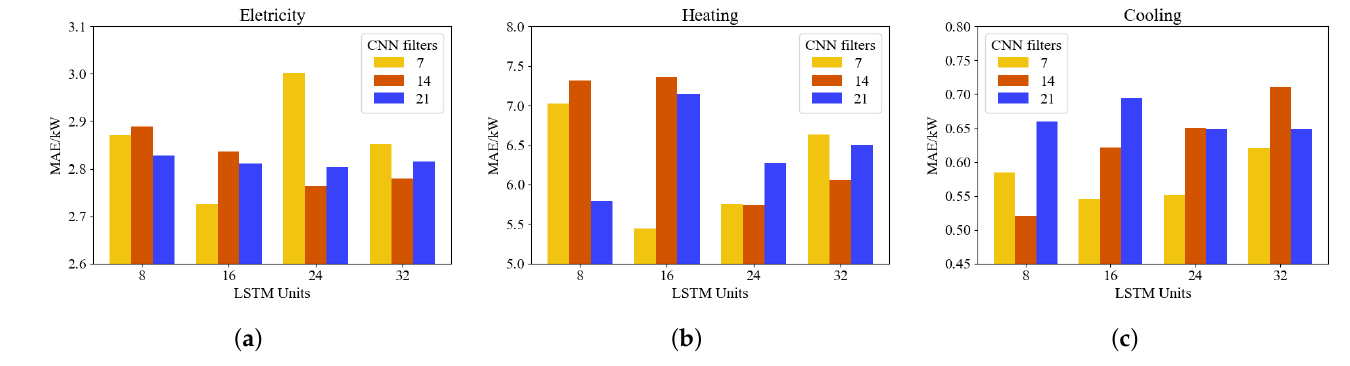
Figure 8. Comparison of the forecasting errors for different combinations of hyper-parameters. ( a ) The histogram of electricity load forecasting error. ( b ) The histogram of electricity load forecasting error. ( c ) The histogram of electricity load forecasting